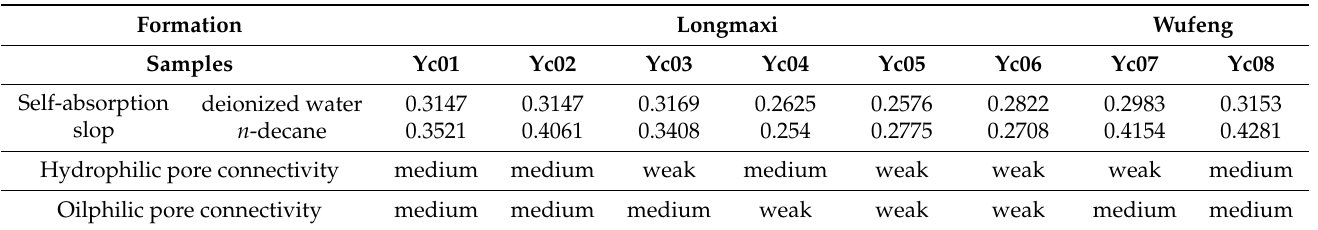
Figure 6. Log plot of the cumulative imbibition of water for shale samples from the Longmaxi and Wufeng Formations. Table 3. Statistical of slopes of self-absorption curves of deionized water and n -decane fluid in Wufeng–Longmaxi Formation in the study